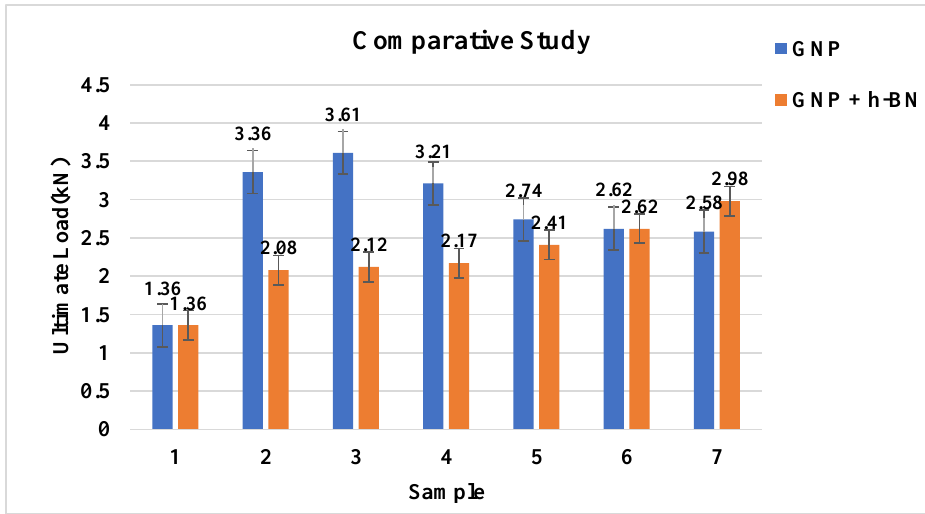
Figure 2. Samples vs. ultimate load of tensile test for composite with GNP and samples vs. ultimate load of tensile test for composite with GNP + h-BN.